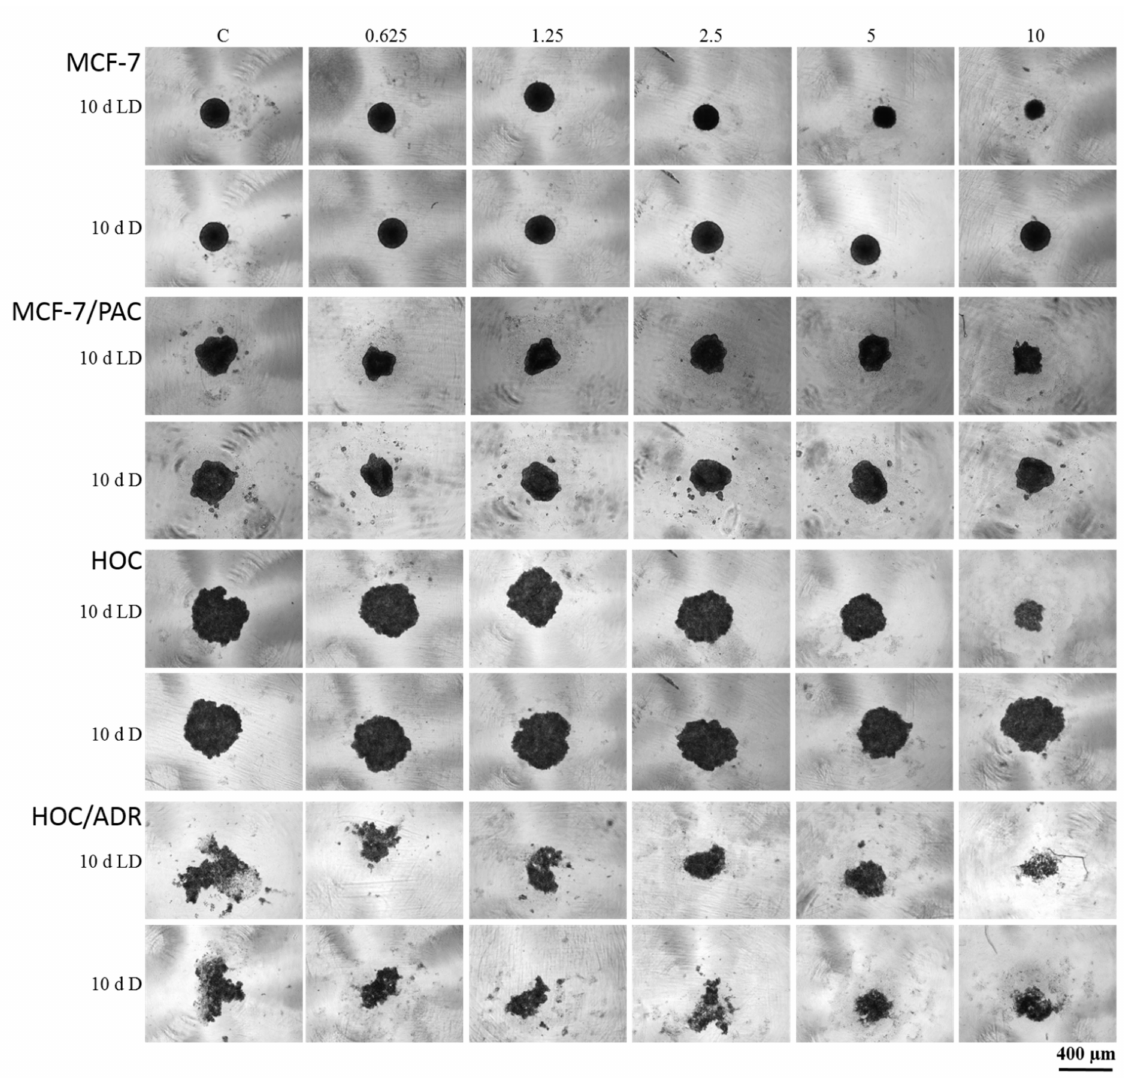
Figure 8. The effect of peptaibol-containing extracts on the formation of spheroids. Tested cells were human breast cancer sensitive (MCF-7) and multidrug-resistant (MCF-7/PAC) cells, human ovarian cancer sensitive (HOC) and multidrug- resistant (HOC/ADR) cells. Tested peptaibol-containing extracts were obtained from a colony of T. atroviride O1 on the 10th day of cultivation (10 d = day) in dark mode (D) or in a circadian rhythm (LD) on PDA agar; the amount of applied extracts was 0.625, 1.25, 2.5, 5, and 10 µ L per 1 mL of cultivation medium (10 d LD = 5.5, 13.1, 21.9, 43.7, and 87.5 µ g/mL, respectively; 10 d D = 7.4, 17.8, 29.7, 59.4, and 118.8 µ g/mL), the time of compound action was 72 h, and a Zeiss Axio Verte.A1, Axiocam Icc 1 was the microscope